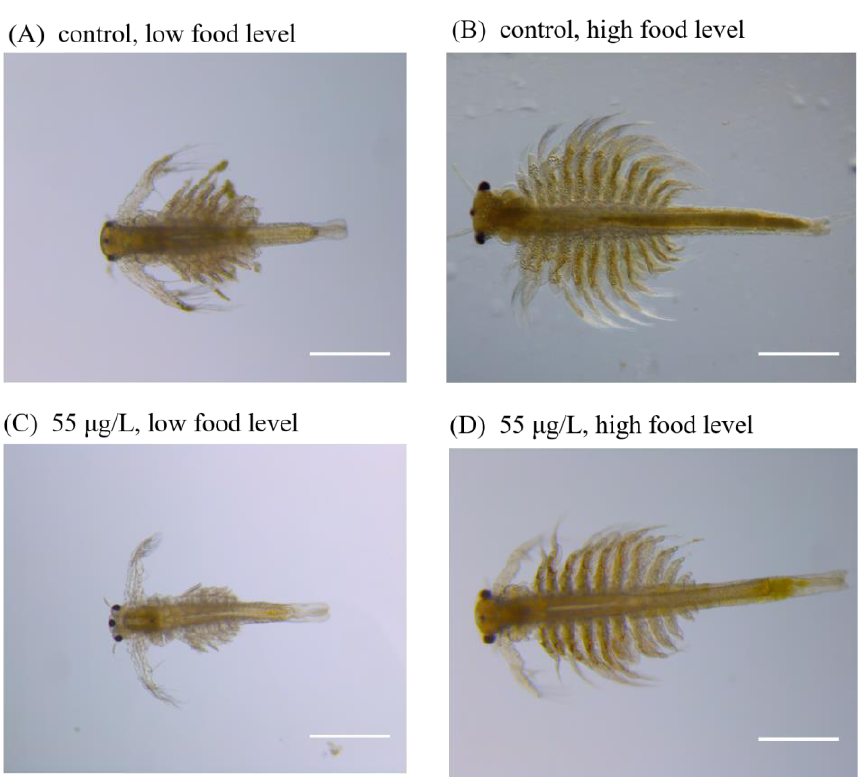
Figure 3. Typical images of A. parthenogenetica at the end of 14 d exposure in Exp. Ia (low food level) and Exp. Ib (high food level) for the control groups ( A , B ) and 1 µ m PS-NH 2 (55 µ g/L) groups ( C , D ). The scale bar is 500 µ